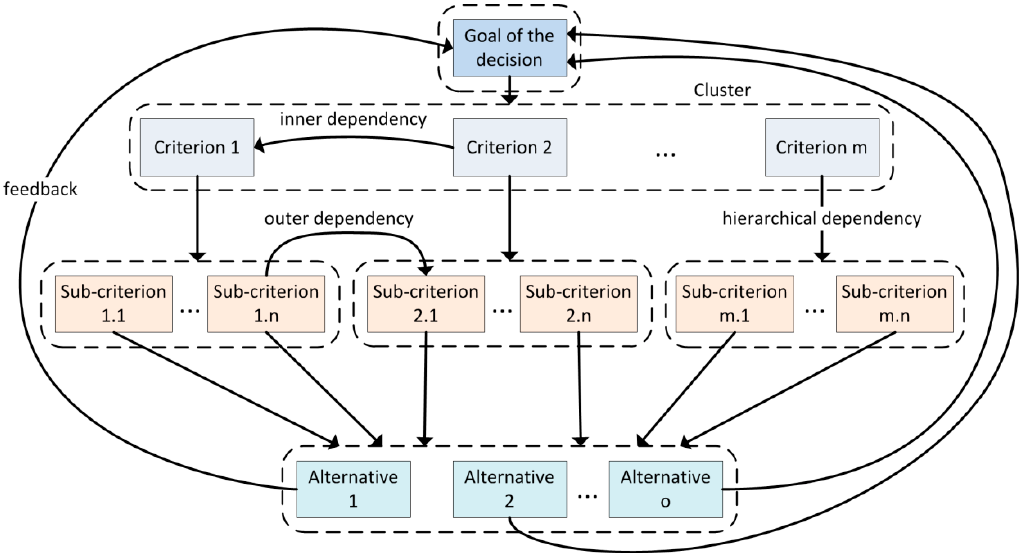
Figure 1. Network structure in the ANP method